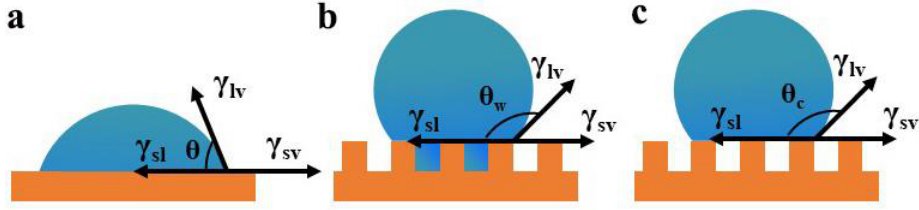
Figure 10. ( a ) Young’s contact angle, ( b ) Wenzel model, and ( c ) Cassie-Baxter